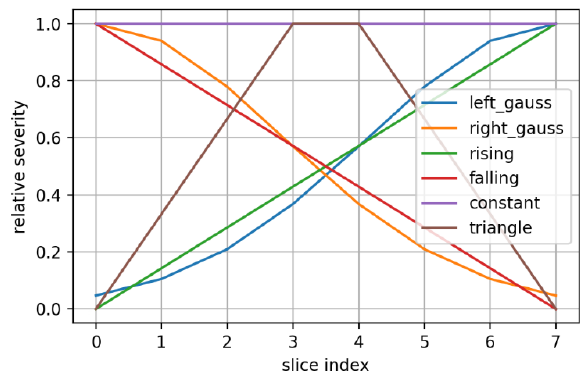
Figure 9. There were 7 perturbation severity variations employed for OoD samples generation. Each slice index has its corresponding relative severity level, according to the chosen severity variation.